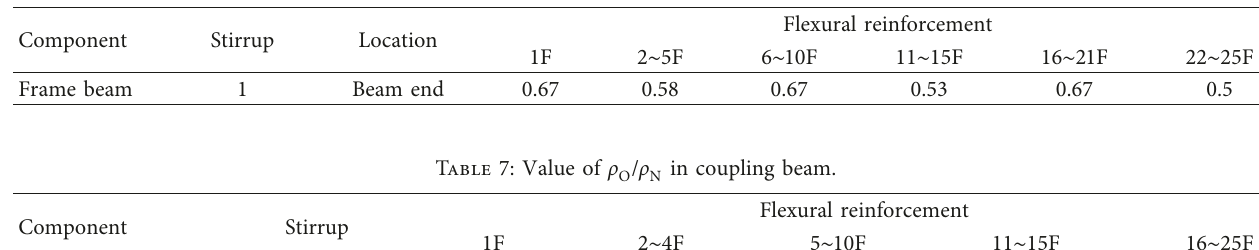
/ ρ in frame beam. O N